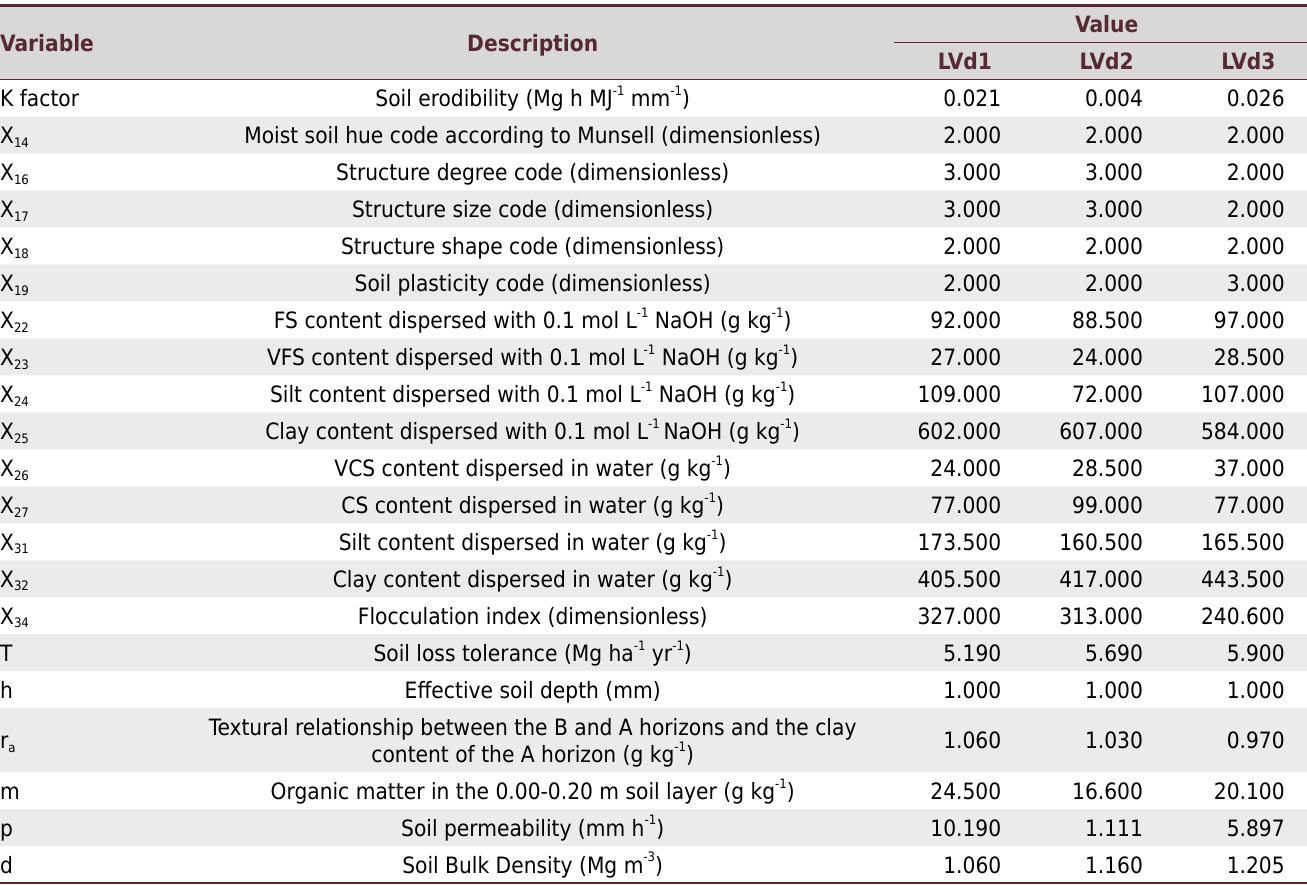
Table 1. Values of K factor, of variables for indirect calculation of erodibility, and of input to obtain soil loss tolerance (T) Variable